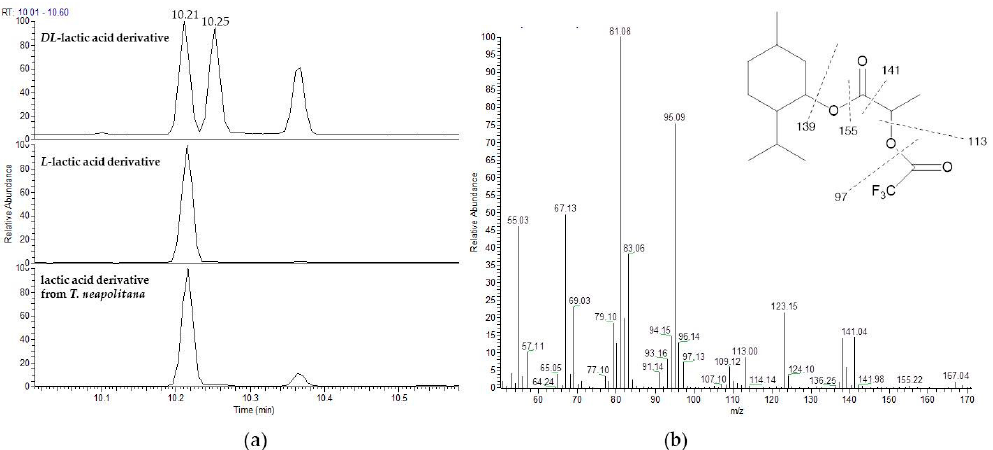
Figure 1. ( a ) The GC/MS of O-trifluoracetyl-(–)-menthyl derivatives of DL-Lactic acid, L-lactic acid and natural lactic acid from T. neapolitana . Chromatograms show L-lactic and D-lactic acid derivatives at Rt of 10.21 min and 10.25 min, respectively; ( b ) mass spectrum and diagnostic fragmentations of the O-trifluoroacetyl-( − )-menthyl ester of lactic acid.